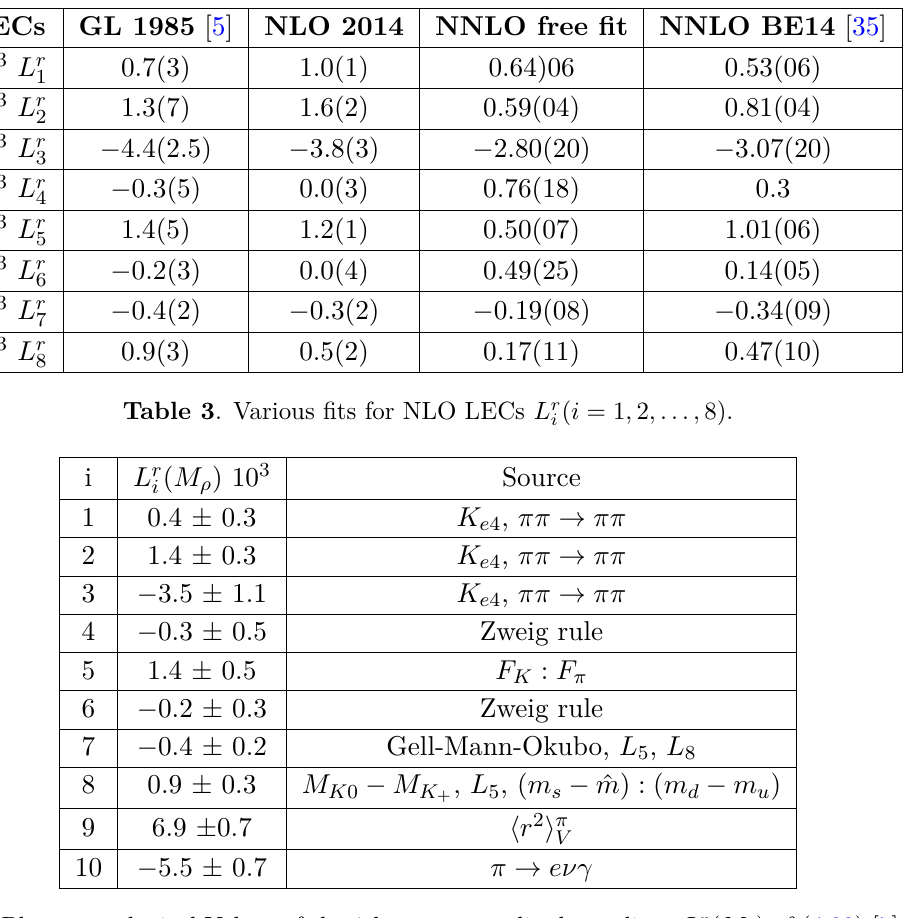
Table 4 . Phenomenological Values of the 1-loop renormalised couplings L r column shows the source to extract this